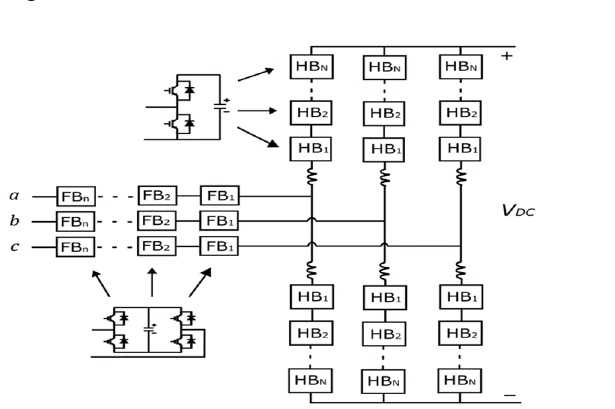
Figure 24. HC-HCMC.